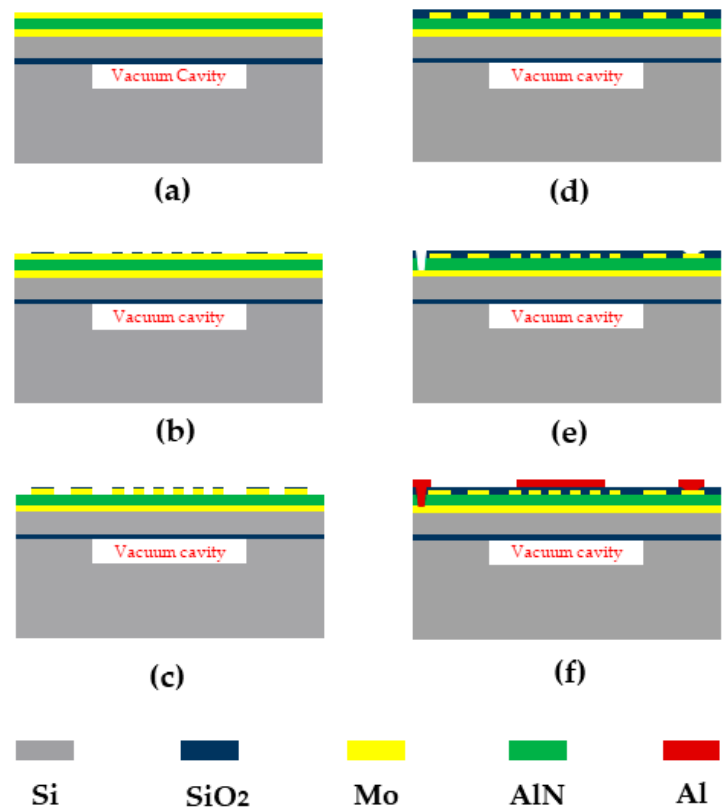
Figure 10. Fabrication process flow of the acoustic wave pressure sensor: ( a ) a stack of 0.2 μ m Mo/0.02 μ m AlN/1 μ m AlN/0.2 μ m Mo is deposited by PVD; ( b ) a 0.2 μ m SiO 2 layer was patterned and etched as a hard mask of the IDT and Bragg reflectors; ( c ) the top Moly is patterned and etched for IDTs and Bragg reflectors structures; ( d ) a 0.7 μ m layer of SiO 2 is deposited and patterned as a temperature compensation layer and an inner layer dielectric to isolate the aluminum connection line and top Moly; ( e ) The bottom and top Moly electrodes contact is opened by DRIE to connecting the Al pad; ( f ) the top Al connection was patterned and deposited to connect the top and bottom Moly electrodes.